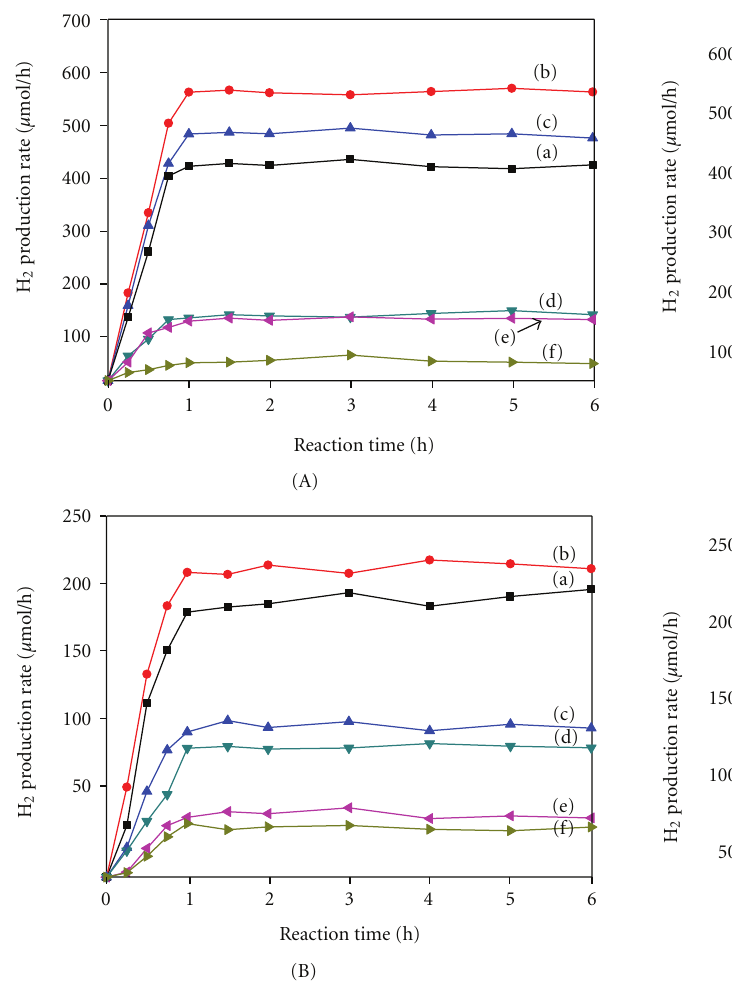
Figure 6: Rates of the photocatalytic H 2 evolution from glycerol solution (5%) over Cd 1 − x Zn x S / SiO 2 samples under UV light (A) and visible light (B): (a) x = 0, (b) x = 0.2, (c) x = 0.4, (d) x = 0.6, (e) x = 0.8, (f) x = 1.